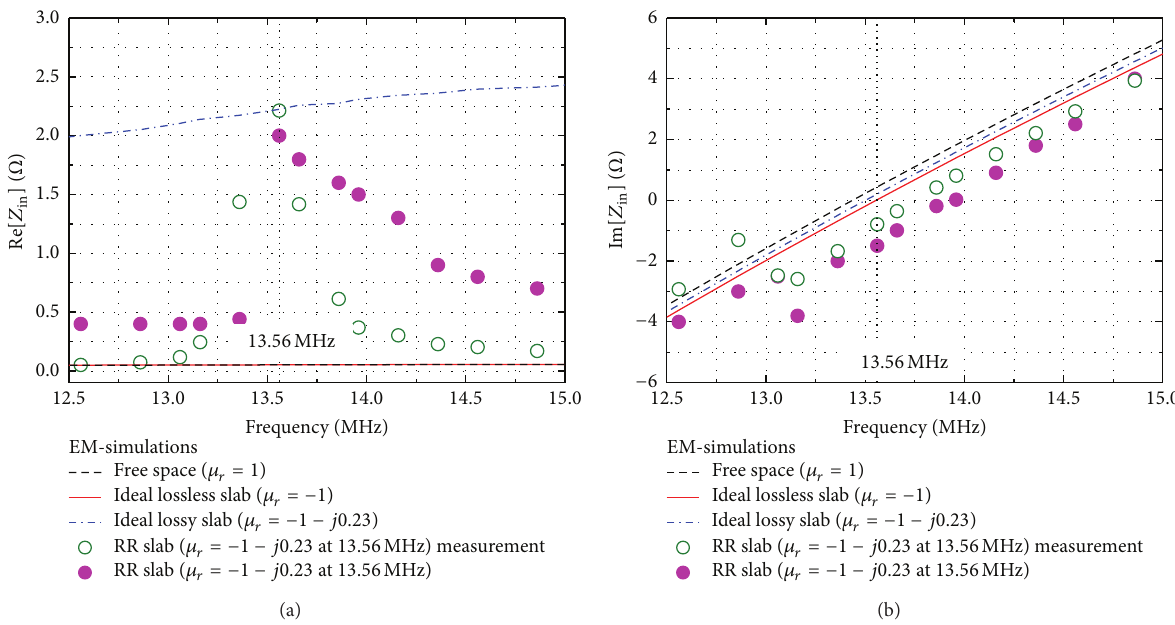
Figure 5: EM-simulated and measured input impedances with loop 2 removed ( 𝑟 12cm, ℎ = 36 cm, and 𝑓 0 = 13.56 MHz). (a) Real parts and (b) imaginary parts.